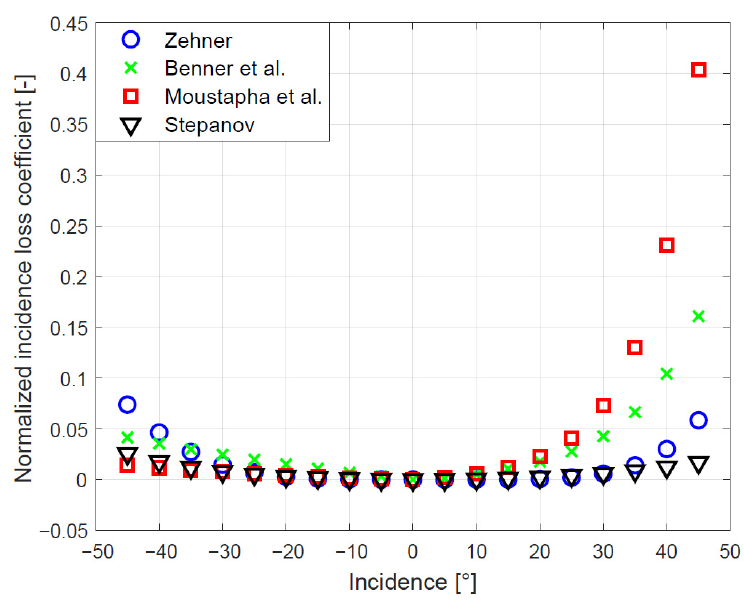
Figure 1. Comparison of incidence loss models.